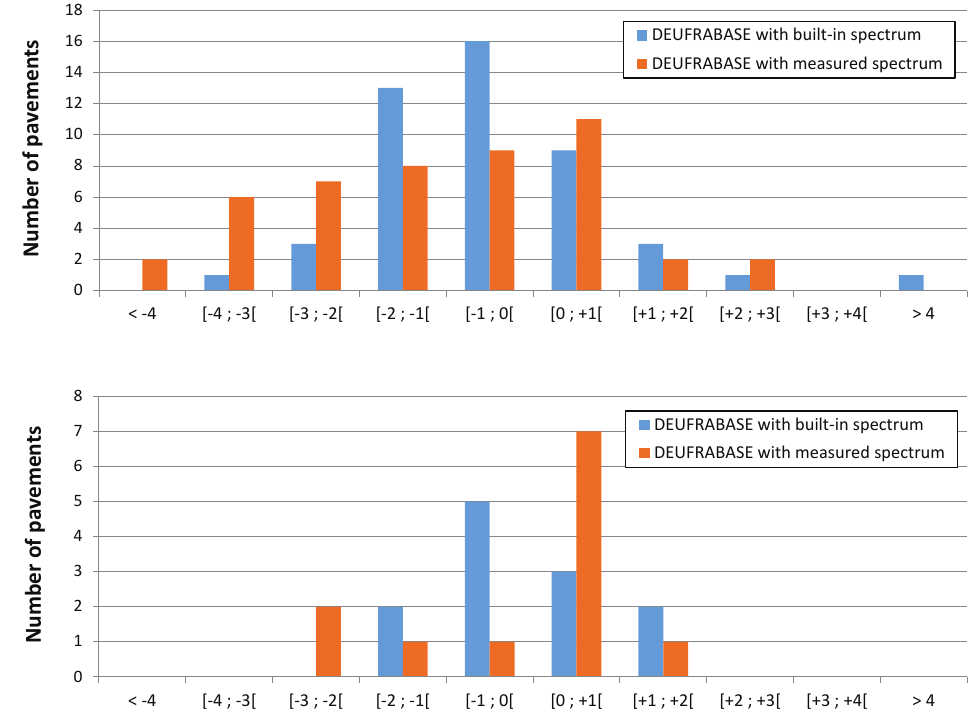
Figure 7. Deviations from measurements, in dB(A), considering all the 47 road pavements ( upper , i.e., ‘worst’ [built-in] and ‘intermediate’ [measured] predictions) and 12 ‘equivalent’ pavements ( lower , i.e., ‘upper-intermediate’ [built-in] and ‘best’ [measured]